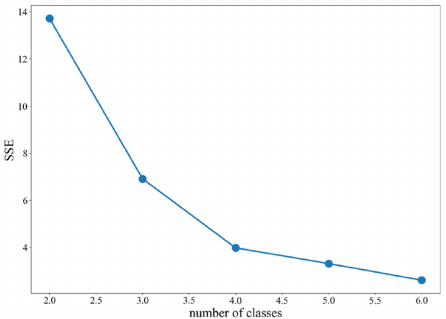
Figure 6. Elbow method results.